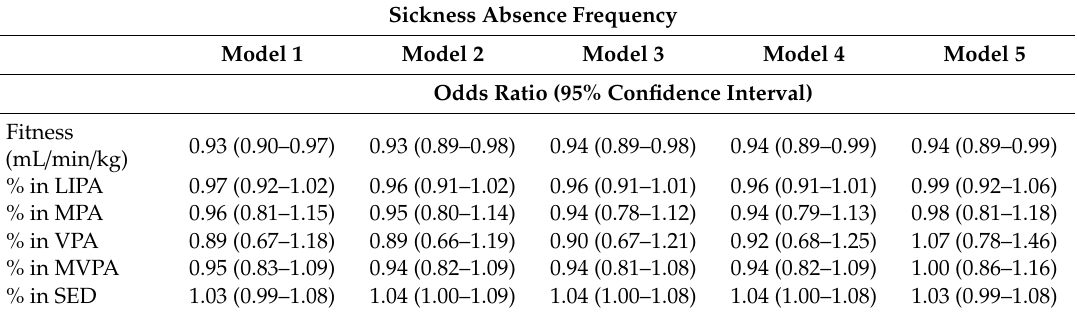
Table 3. Odds of sickness absence ≥ 2 times per year according to baseline fitness, and percentage in LIPA, MPA, VPA, MVPA, and SED ( n =